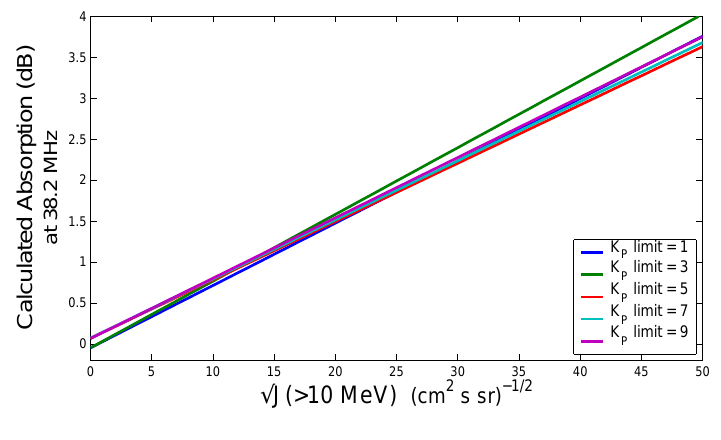
Fig. 8. Flux-absorption relationship calculated for various upper limits of K p . Note the increase away from zero intercept for higher K p . Overall, the gradient drops between K p = 3 and 9, however, the gradient rises from K p =1 and from K p = 5. The values of the co- efficients are displayed in Table